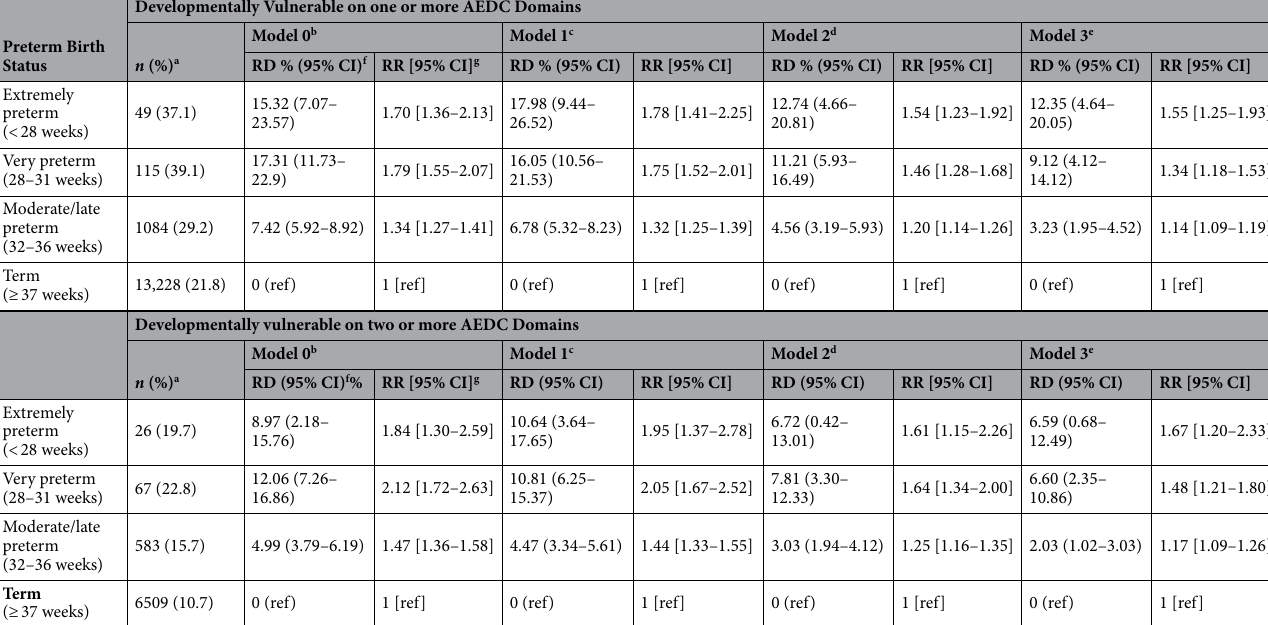
Table 2. Risk difference (RD) and relative risk (RR) from interaction models for the association between developmental vulnerability on the Australian Early Developmental Census (AEDC) and preterm birth status. Developmental vulnerability was defined as scores in the bottom decile, based on the 2009 AEDC cut-offs. Adjusted models based on pooled analysis from 20 imputed datasets; modified Poisson Regression ( n = 64,810 children). a Number of children classified as developmentally vulnerable. b Model 0 was unadjusted. c Model 1 was adjusted for sex of child and age of child at time of AEDC completion. d Model 2 was adjusted for all variables as per Model 1 and for sociodemographic and maternal confounders (maternal age at time of child’s birth, maternal marital status at time of child’s birth, maternal immigration status, ethnicity of mother, maternal occupational status at time of child’s birth, parity, child speaks a language other than English at home, total number of siblings, and Index of Relative Socioeconomic Disadvantage category). e Model 3 was adjusted for all variables as per Model 2 and controlled for modifiable variables (preschool attendance and child’s reading status at home). f Data presented as Risk Difference (95% Confidence Intervals). g Data presented as Relative Risk [95% Confidence